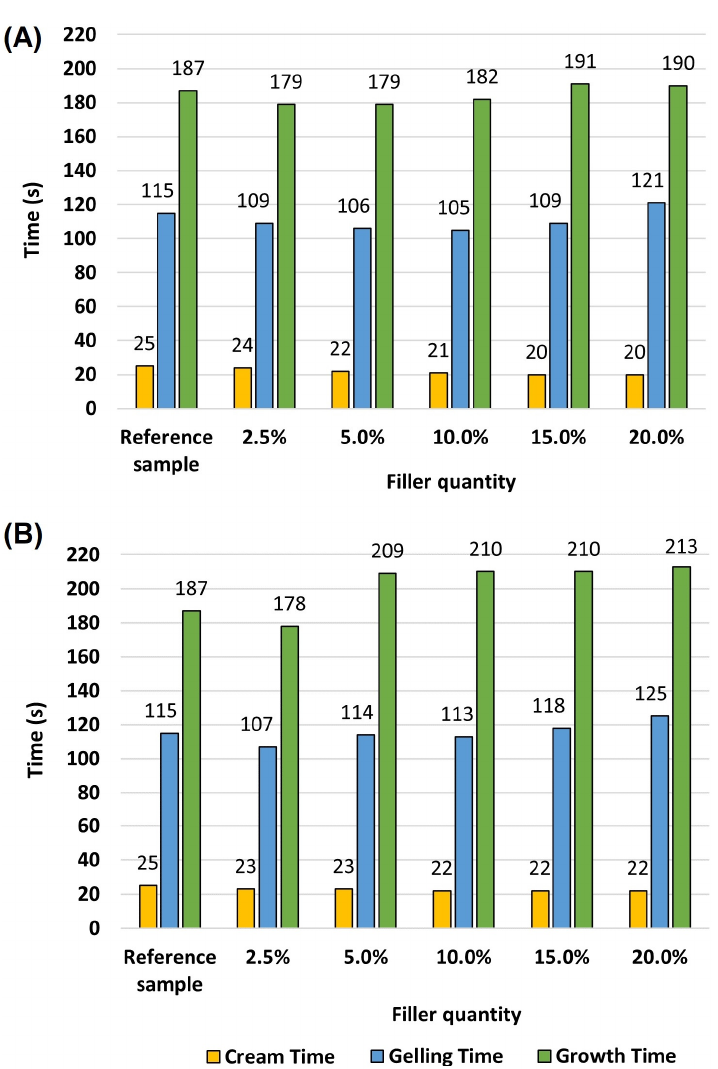
Figure 2. Characteristic processing times for polyurethane + coffee grounds ( A ) and oak sawdust ( B ).